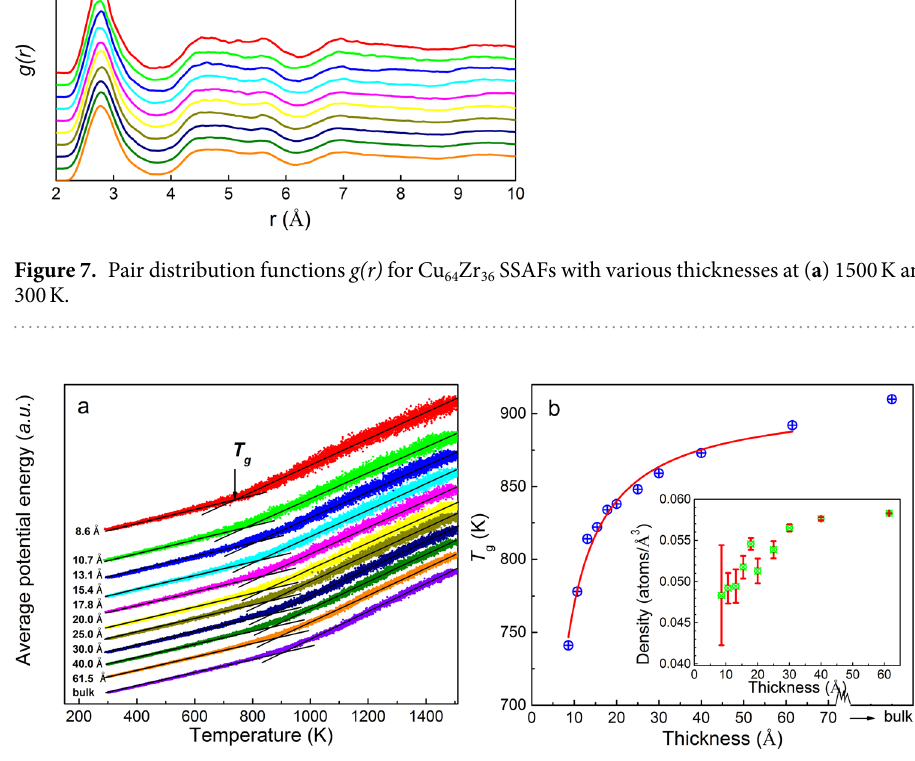
Figure 8. ( a ) Determination of glass transition temperature T g via an intersection of low- and high-temperature dependences of the potential energy in Cu 64 Zr 36 SSAFs with different thicknesses and bulk Cu 64 Zr 36 MG. ( b ) The film thickness dependent T g of Cu 64 Zr 36 SSAFs with different thicknesses together with the fitting curve, which is explained in text. And the inset picture is atomic number density as a function of film thickness for Cu 64 Zr 36